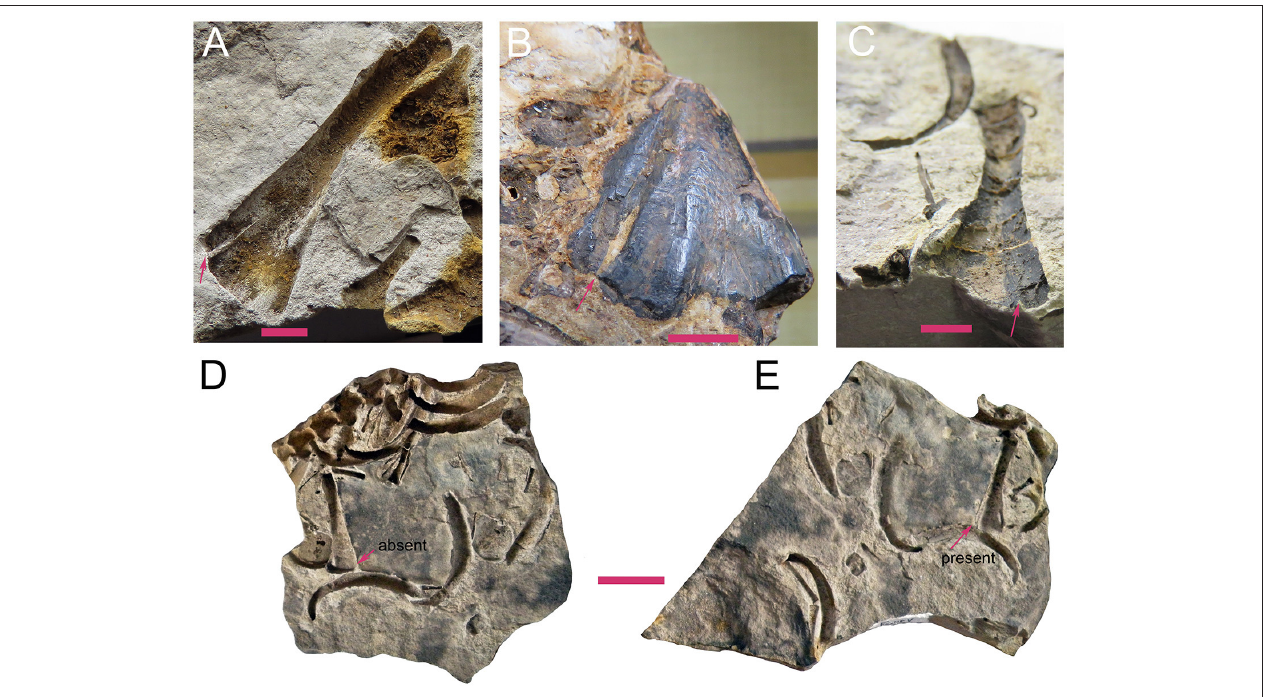
FIGURE 4 | Specimens of Mesosaurus tenuidens showing how part and counter-part can lead to divergent interpretations about the presence of the ectepicondylar foramen. (A–C) FC-DPV 2042, 2488, and 2103, respectively, photographs of several humeri of adult individuals from the Mangrullo Formation of Uruguay, showing the presence of both ectepicondylar foramen (red arrow) and groove. Scale bars: 3mm. (D,E) . FC-DPV 2385 photographs of a partially articulated mesosaur trunk region preserved as part (D) and counterpart (E) . The humerus in (D) suggests that the ectepicondylar foramen is not present, but it can be perfectly seen in (E) . Scale bar: